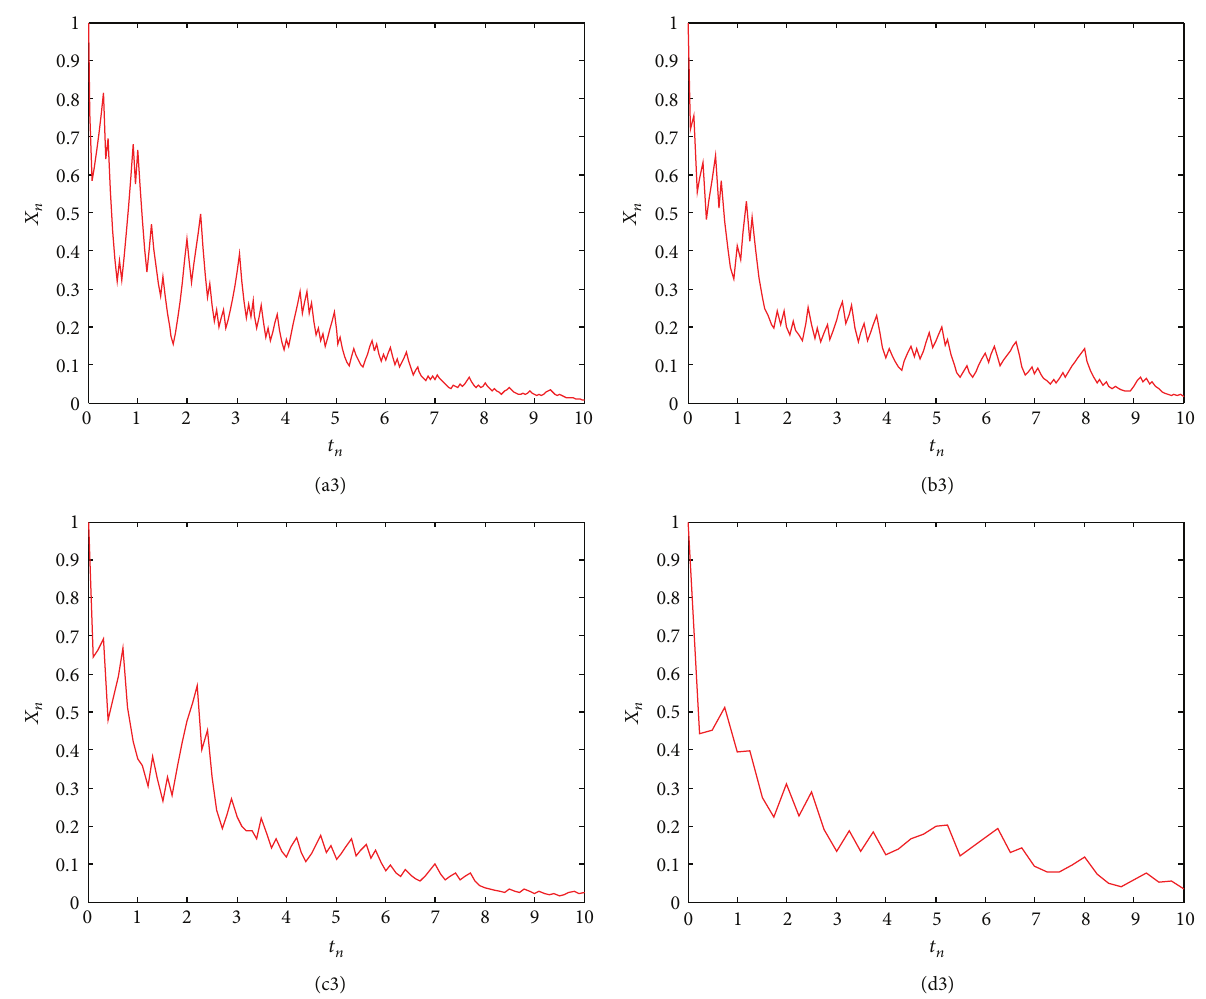
Figure 3: Simulations with the balanced method for (6) with 𝑎 = −3, 𝑏 = 2 , and 𝑐 = 1 . ( a 3) ℎ = 1/22 , ( b 3) ℎ = 1/16 , ( c 3) ℎ = 1/10 , and ( d 3) ℎ = 1/4